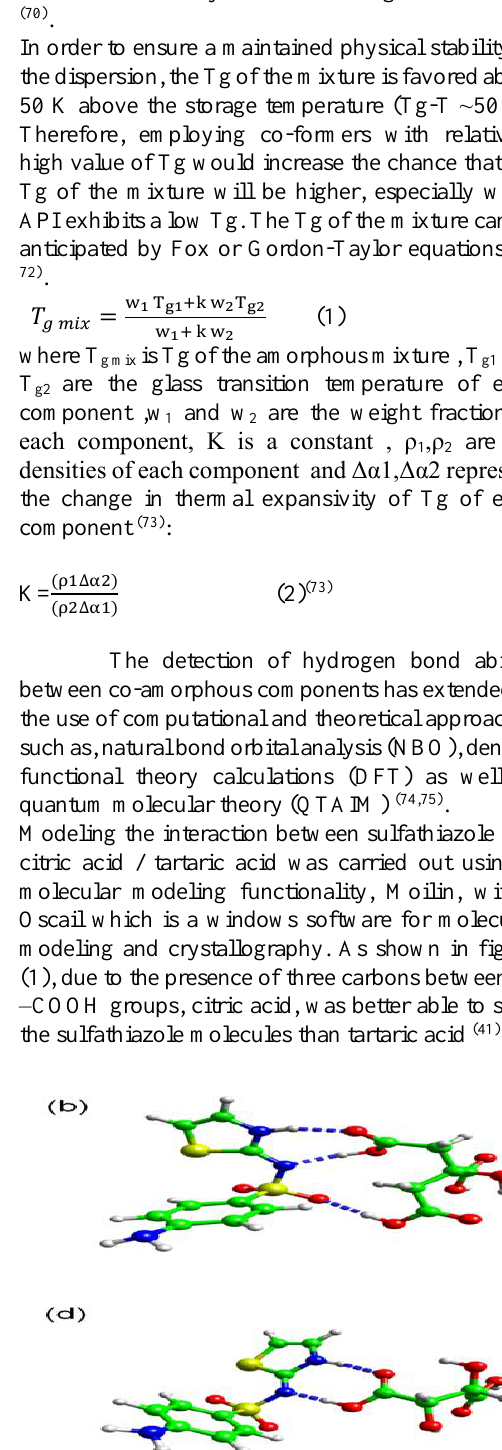
systems would have a value of